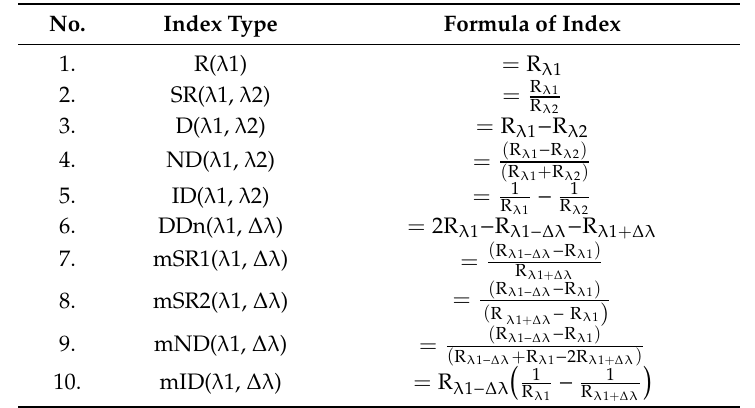
Table 3. Index types used for developing new indices: Spectra at given wavelength (R), simple ratio (SR), wavelength di ff erence (D), normalized di ff erence (ND), inverse di ff erences (ID), double di ff erences (DDn), modified simple ratio 1 (mSR1), modified simple ratio 2 (mSR2), modified normalized di ff erence (mND) and modified inverse di ff erences